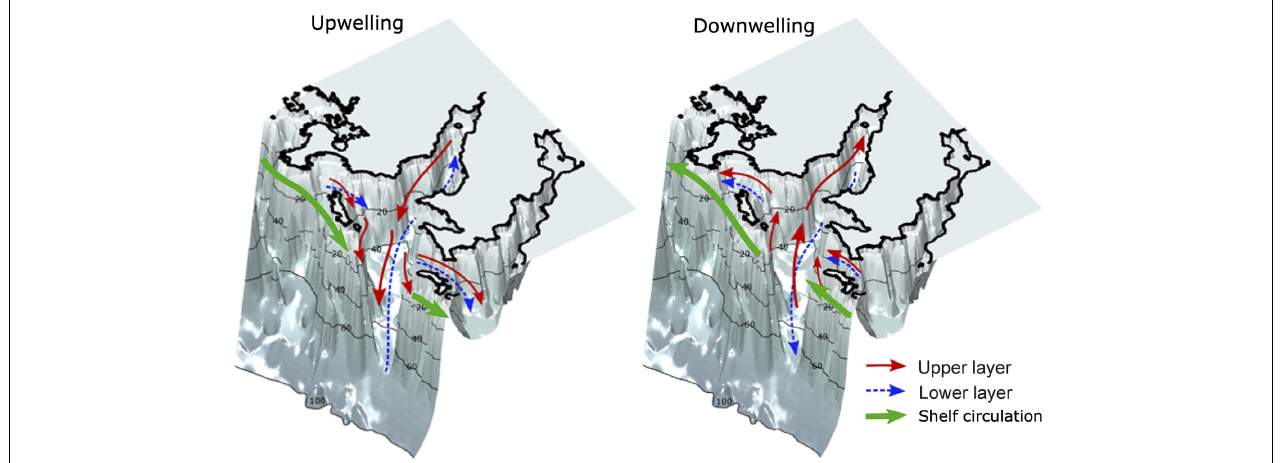
FIGURE 11 | Scheme of the circulation patterns under upwelling and downwelling events. Colors of arrows are depicted in the legend (right bottom